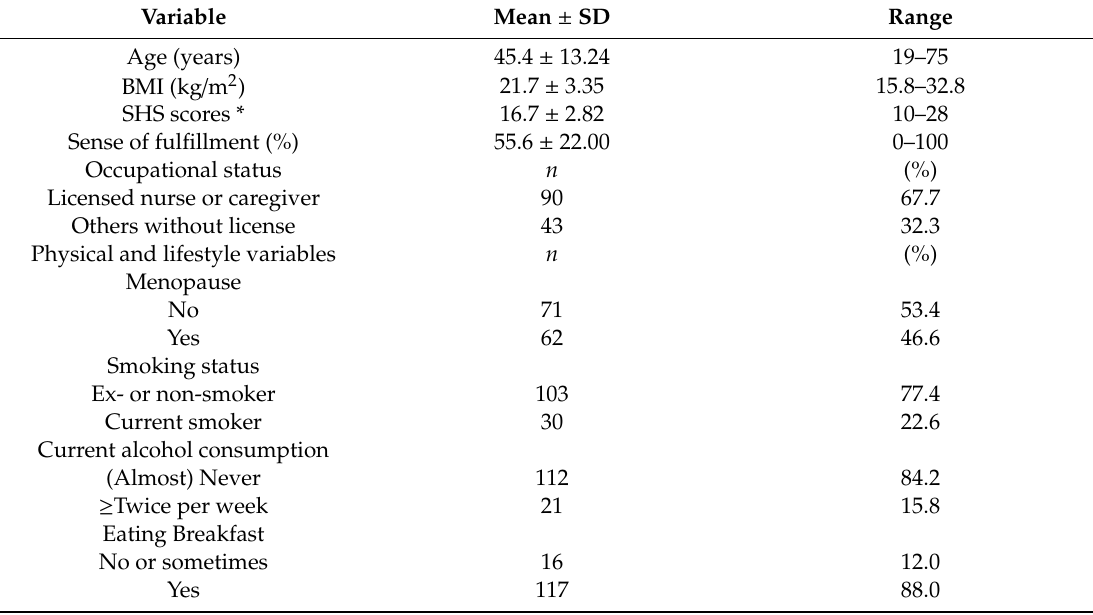
Table 1. Characteristics and clinical variables of the participants ( n =